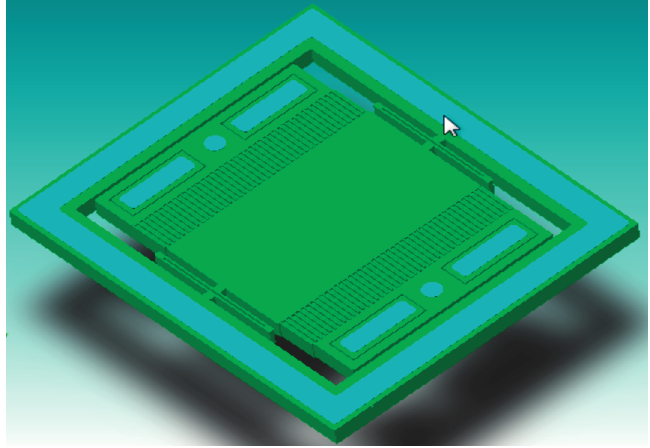
Figure 1. 3-D Model of the single-axis capacitive